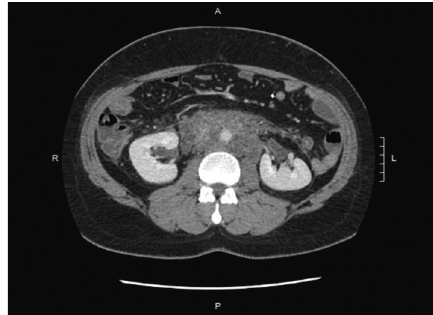
Figure 2: CT imaging of the abdomen and pelvis reveals large retroperitoneal process with dense infiltrative tissue extending along the aorta at day 9.